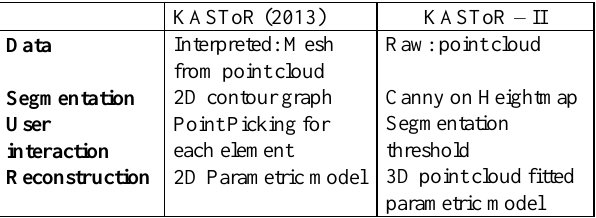
Table 2. Advances and Improvements from KASToR (2013)